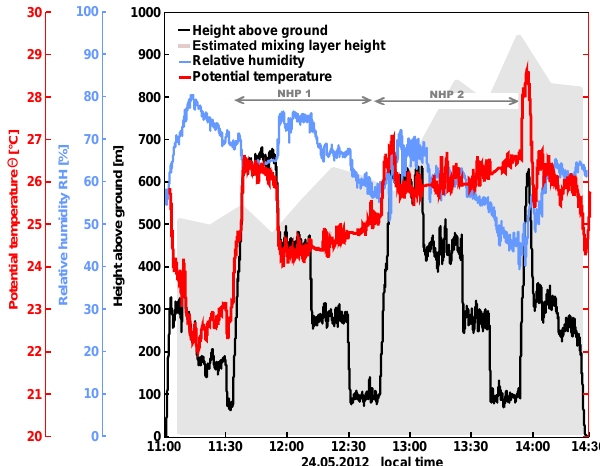
Figure 10. Ground measurements of the aerosol particle chemi- cal composition at the Cabauw tower during NHP1 and NHP2 on 24 May 2012. HR-ToF-AMS and MAAP results are combined for the total aerosol mass. Also, the averaged mass concentrations dur- ing the profile periods are